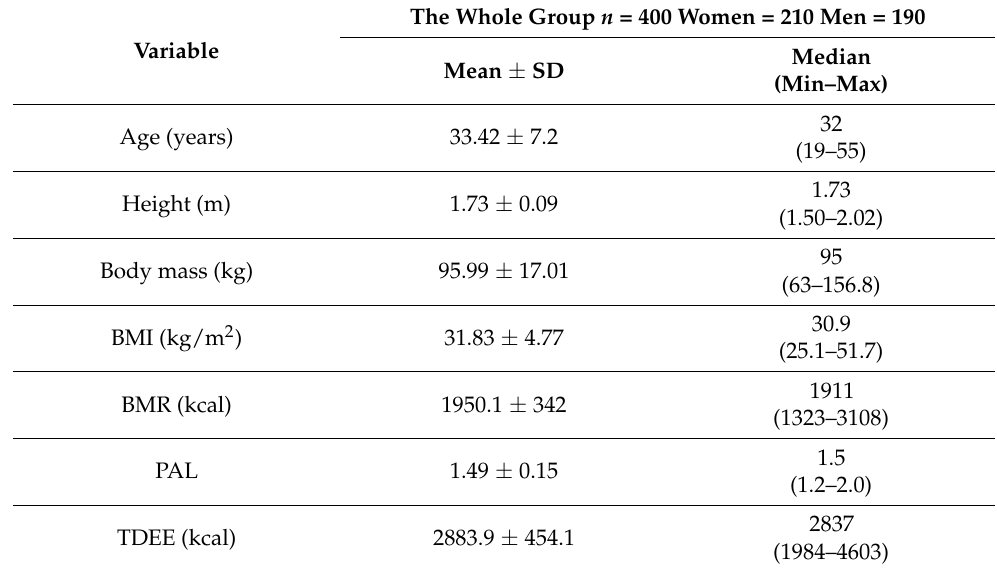
Table 2. Characteristics of all individuals observed at the beginning of the intervention without grouping.